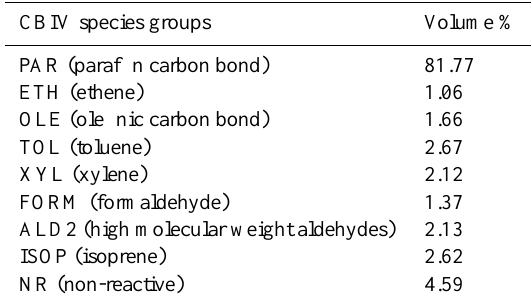
Table 1. Estimated VOC composition of emissions during 05:00– 15:00LT in July in the Tokyo Metropolitan